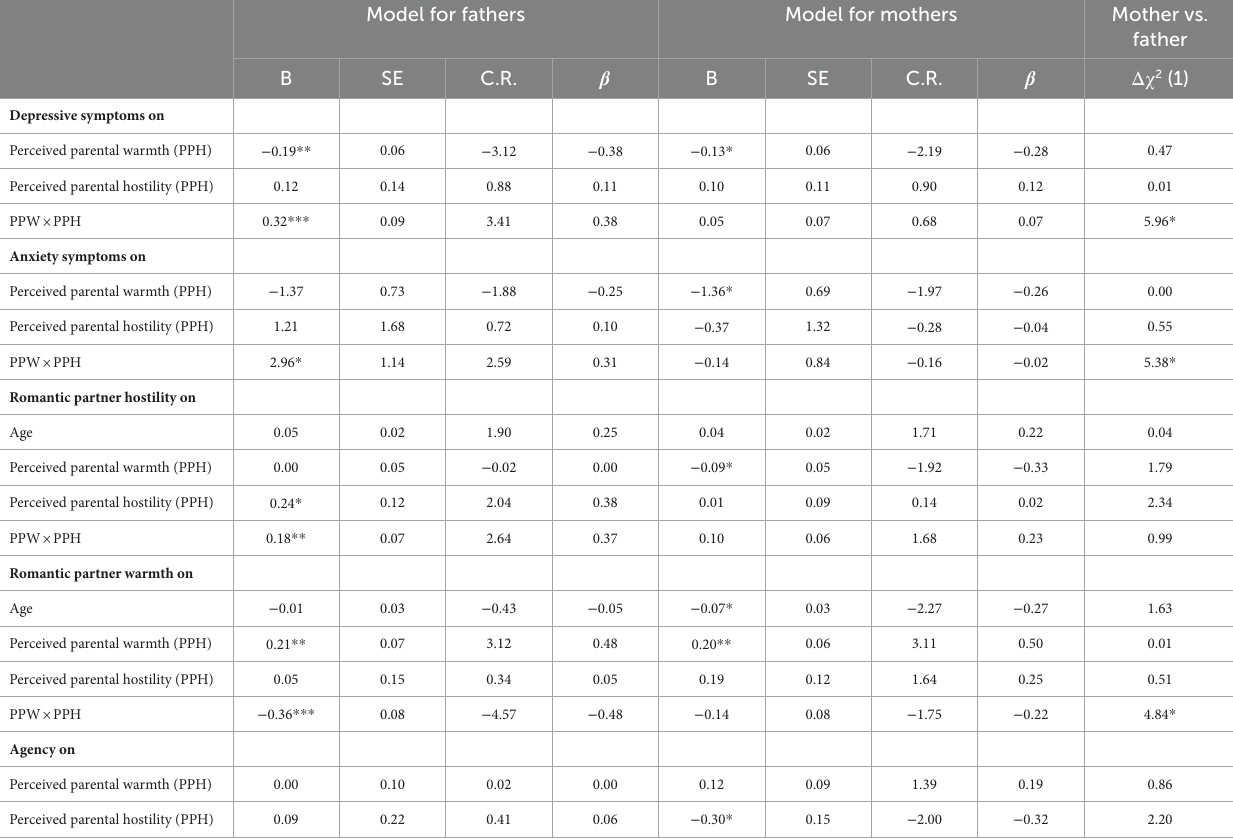
TABLE 2 Unstandardized and standardized coefficients for the mother-daughter and father-daughter